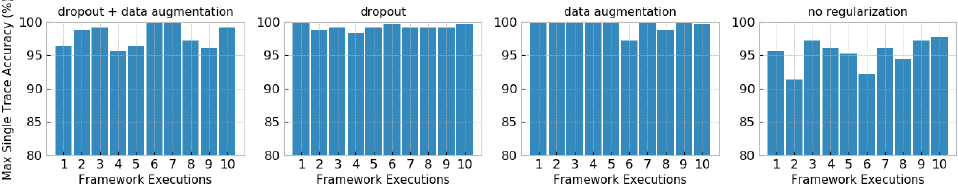
Figure 18: Fixed CNN hyperparameters: maximum single trace accuracy on the cswap- pointer dataset for ten different framework executions.